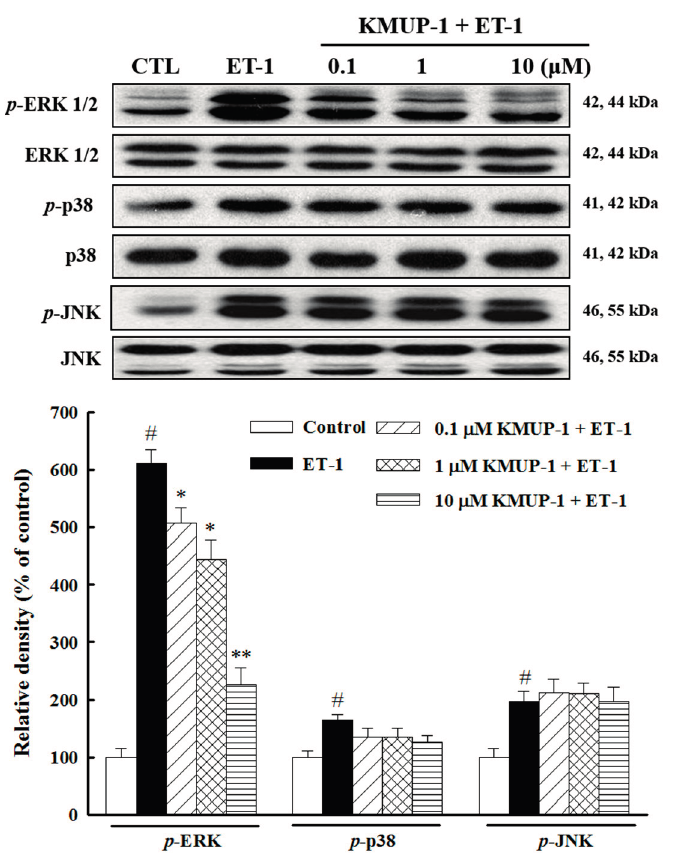
Figure 3. Effects of KMUP-1 on the activations of MAPKs pathway. H9c2 cells